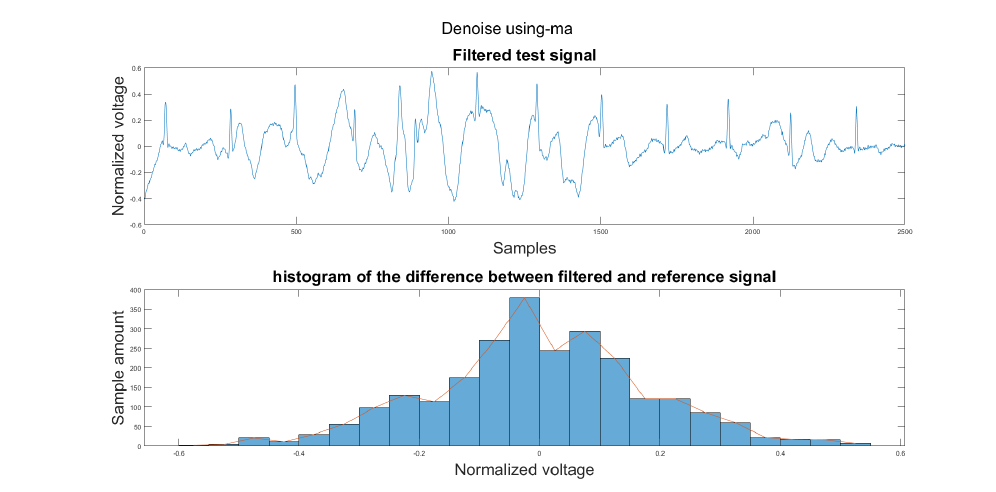
Figure A9. (1) Test signal, (2) histogram of the difference.